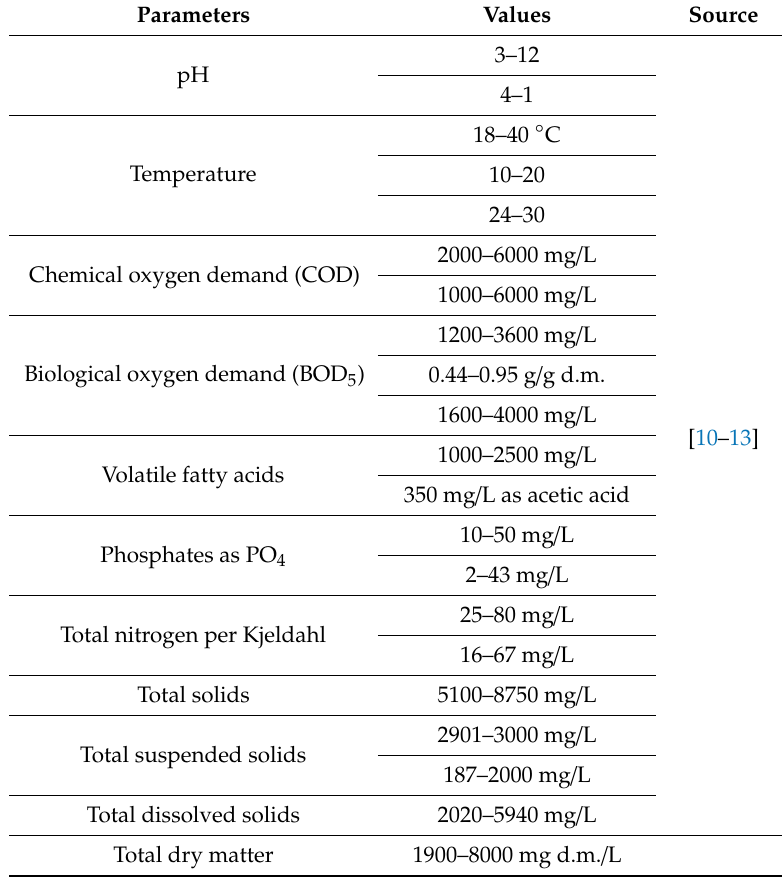
Table 1. Chemical composition of wastewater from breweries according to di ff erent